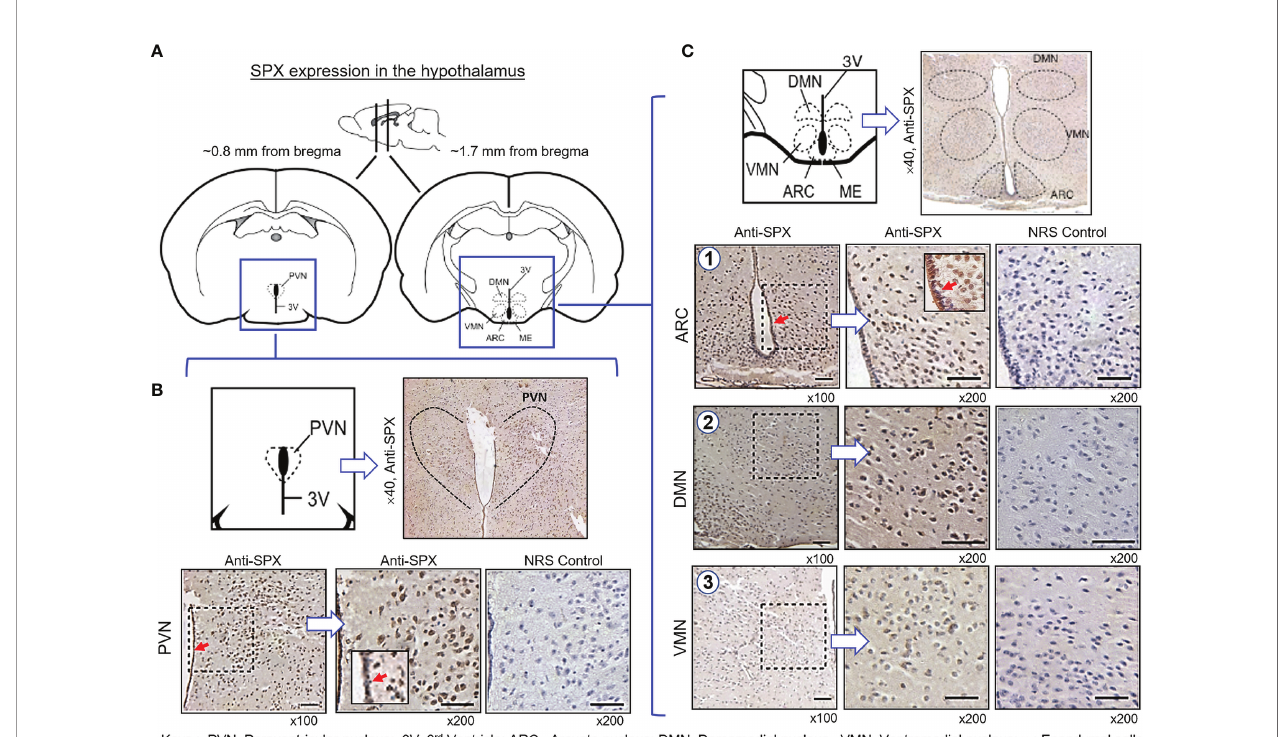
FIGURE 10 | Histological distribution of SPX expression in the hypothalamus. (A) Brain sectioning to obtain the hypothalamus region for IHS with anti- SPX. Using the co-ordinates of stereotaxic atlas of mouse brain (with the bregma as a reference), cross-sections of the hypothalamus covering the areas of paraventricular nuclei (~0.8 mm from bregma) and dorsomedial, ventromedial and arcuate nuclei (~1.7 mm from bregma) were prepared and used for IHS study. (B) SPX expression in the anterior region of the hypothalamus. SPX immunoreactivity was detected in the glial cells forming the matrix of the hypothalamus, neuronal clusters forming the PVN, and ependymal cells in the boundary of the 3 rd ventricle. (C) SPX expression in the posterior region of the hypothalamus. SPX signals in glial cell matrix and ependymal cells surrounding the 3 rd ventricle could still be noted. SPX immunostaining was also found in the neuronal clusters forming the DMN, VMN and ARC nuclei. In this study, parallel staining with NRS was used as the negative control and the numbers on the side (×40, ×100, and ×200) represent the magni fi cation of the respective